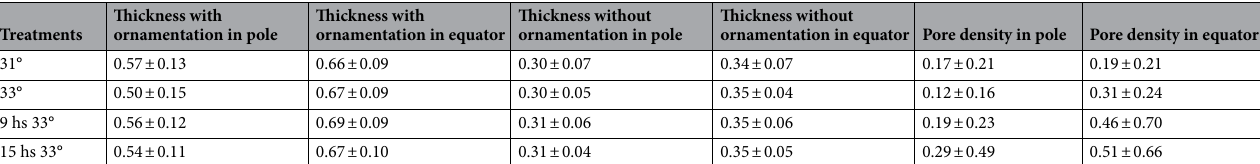
Table 2. Thickness (mm) with and without ornamentations for the pole and the equator, and pore density (pores/mm 2 ) for the different temperature treatments (mean ± standard